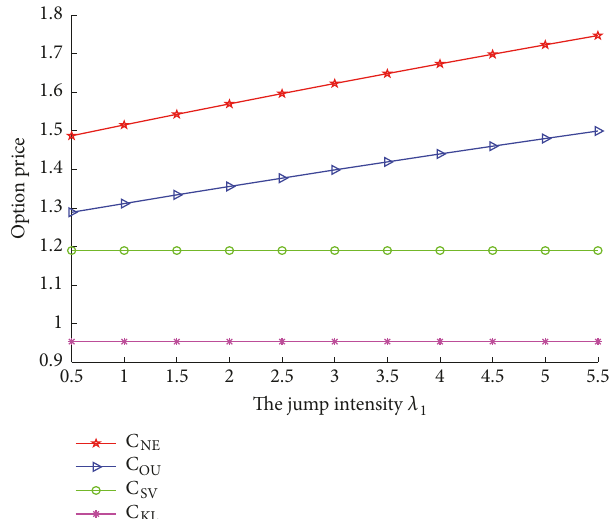
Figure 4: The effect of the jump intensity 𝜆 1 on the option prices.